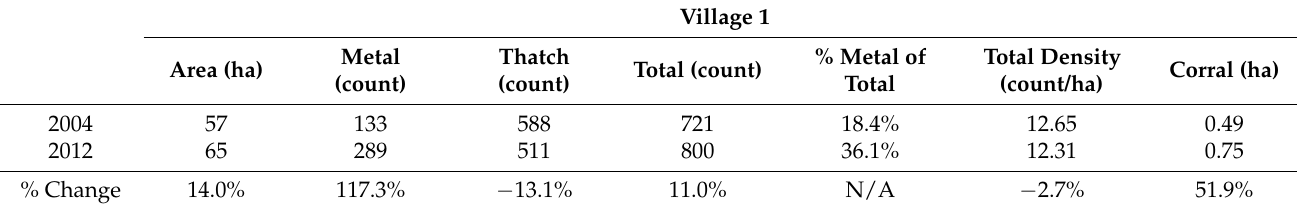
Figure 4. The classification maps ( left : 2004, middle : 2012) for Village 1 based on the 2004 and 2012 VHR images. The right panel shows the 2012 VHR image for reference. Table 6. The changes in the village extent, the number of roofs, the total area of corrals in both villages between 2004 and 2012 based on the classification results. Green and red indicate increased and decreased trends, respectively.